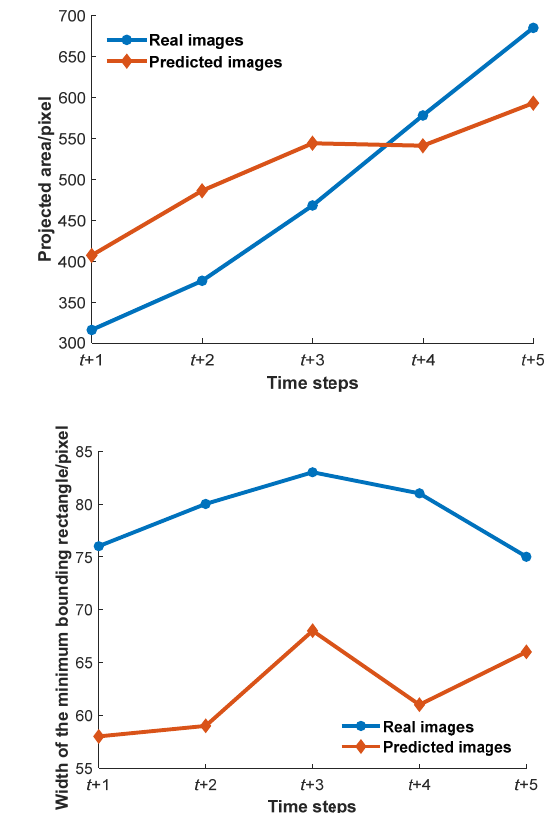
Figure 10. Comparison between the predicted images of panicoid grain crops and the real images of future growth and development of the experimental results on the Panicoid Phenomap-1 dataset.